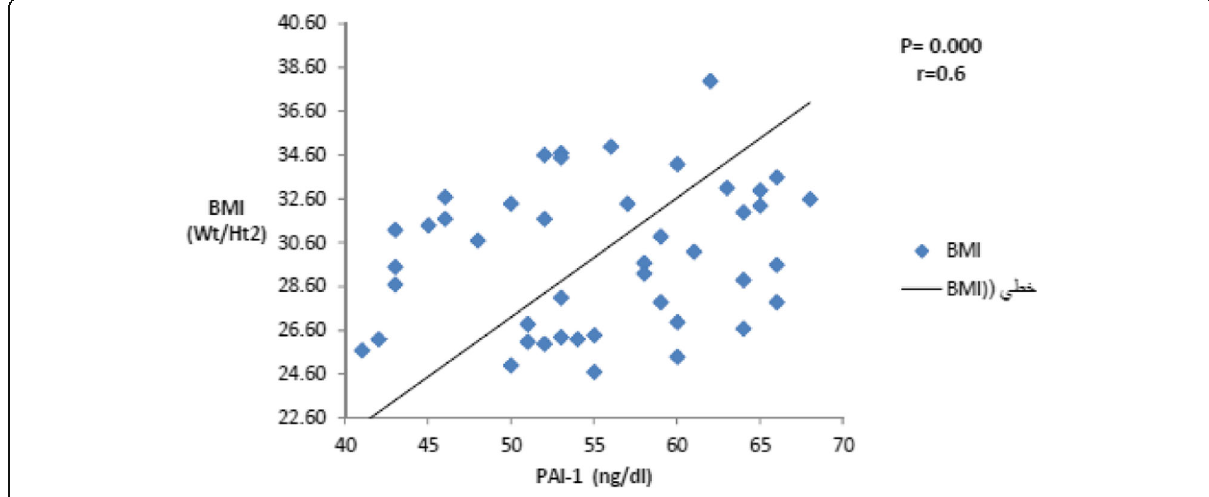
Fig. 1 Correlation between PAI-1 and BMI in obese group